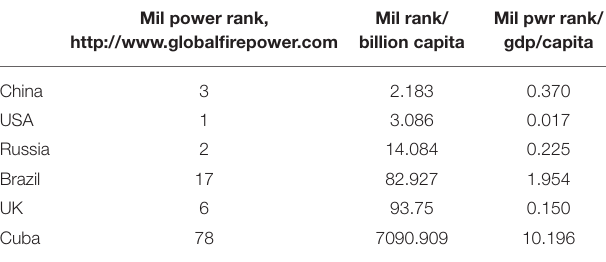
TABLE 1 | Data rounded off to three significant